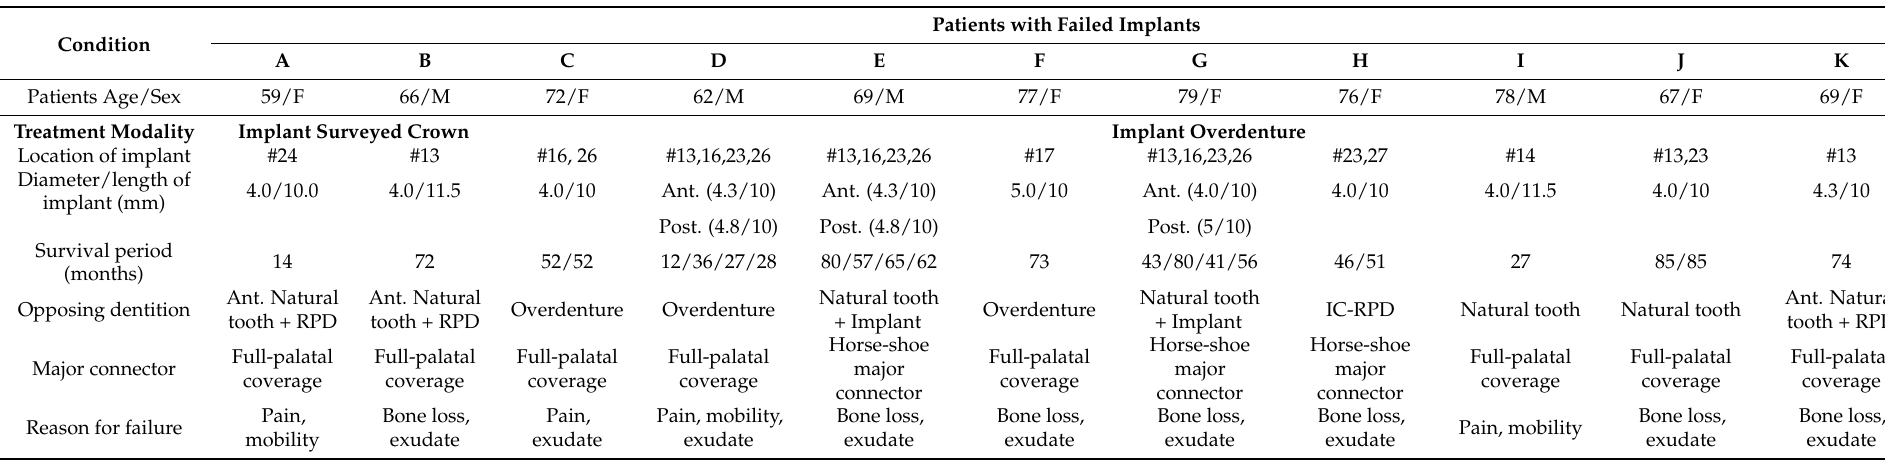
Table 4. Detailed information for 23 failed